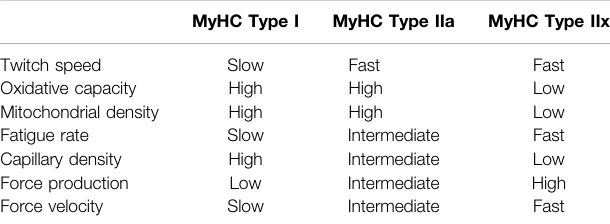
TABLE 1 | General characteristics of muscle fi ber types in normal, healthy muscle of